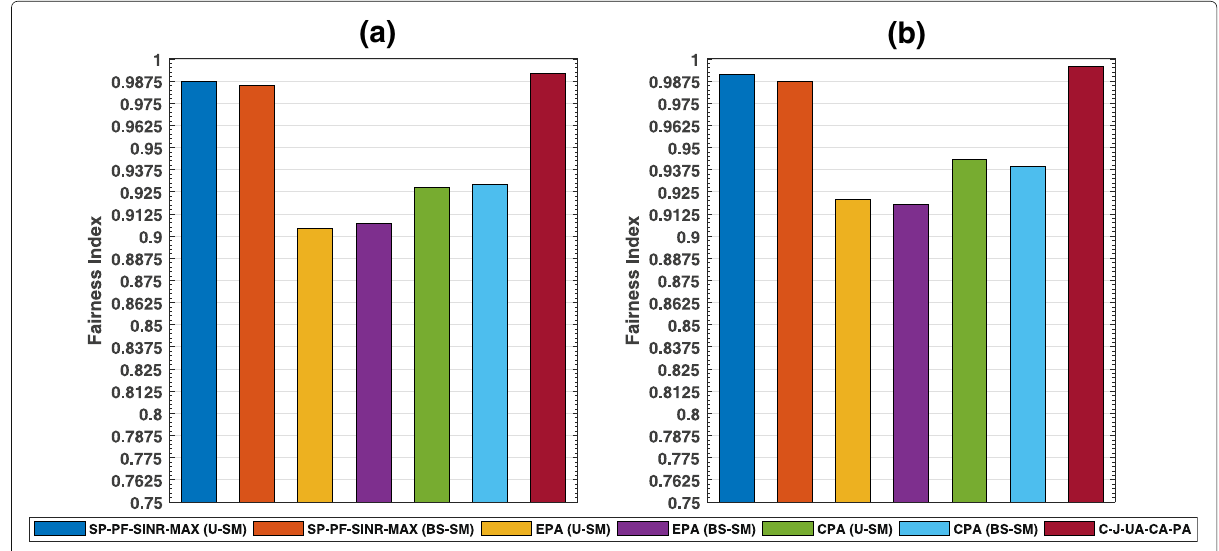
Fig. 5 Jain’s fairness index: a Scenario 1 and b Scenario